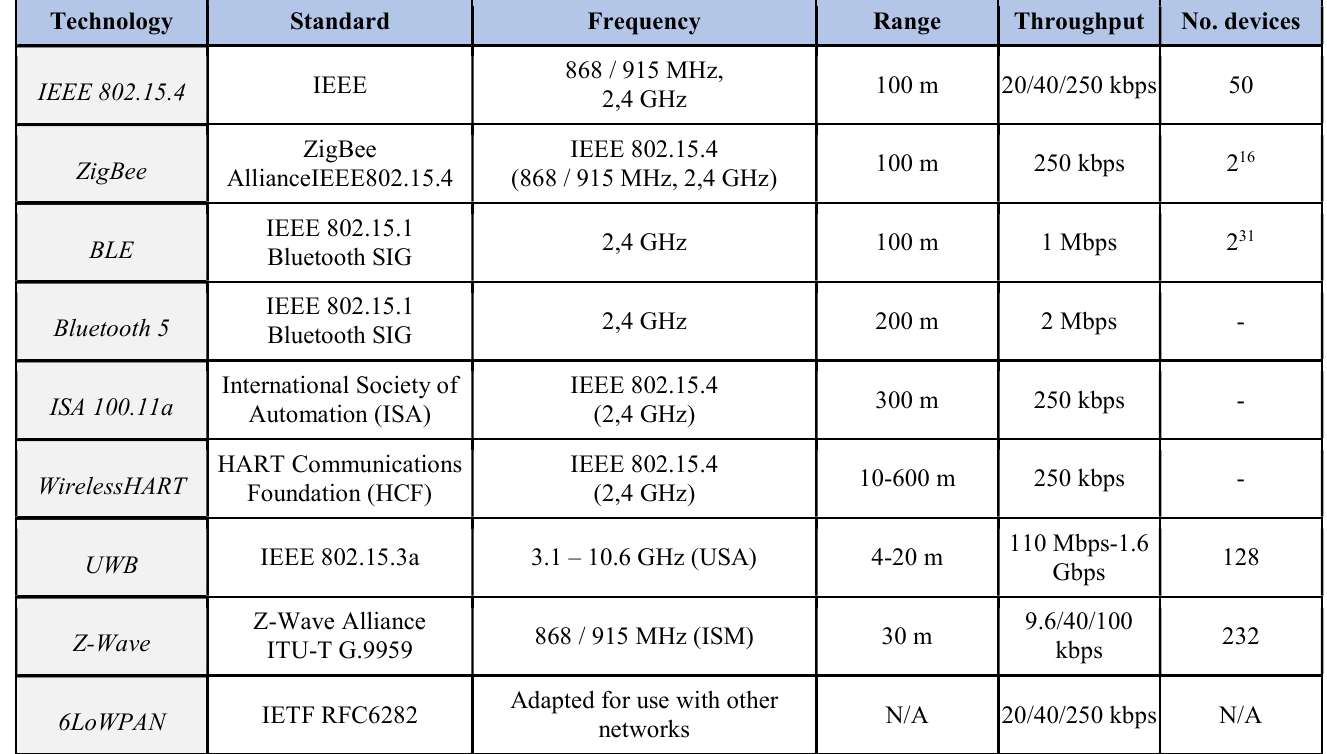
Table 4. An overview of LR-WPAN